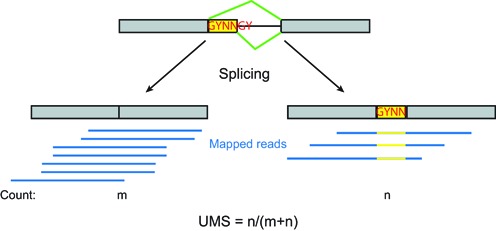
The diagram of AS at GYNNGY 5′ splice site as well as strategy of detecting such AS events by mapped reads. The formula for calculating the UMS is also given. The diagram shows the case of using the second GY as the minor form, but in reality the first GY can also be minor form.